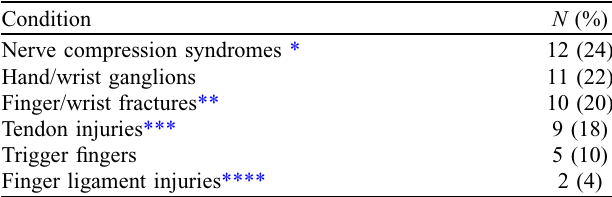
Table 1. Characteristics of patients admitted for hand/wrist surgery in São Paulo University Hospital, 2015.